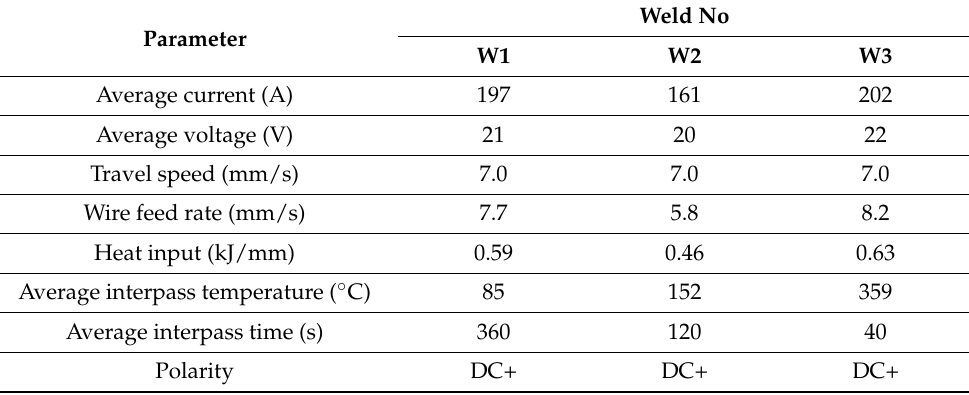
Table 2. Layer deposition parameters.